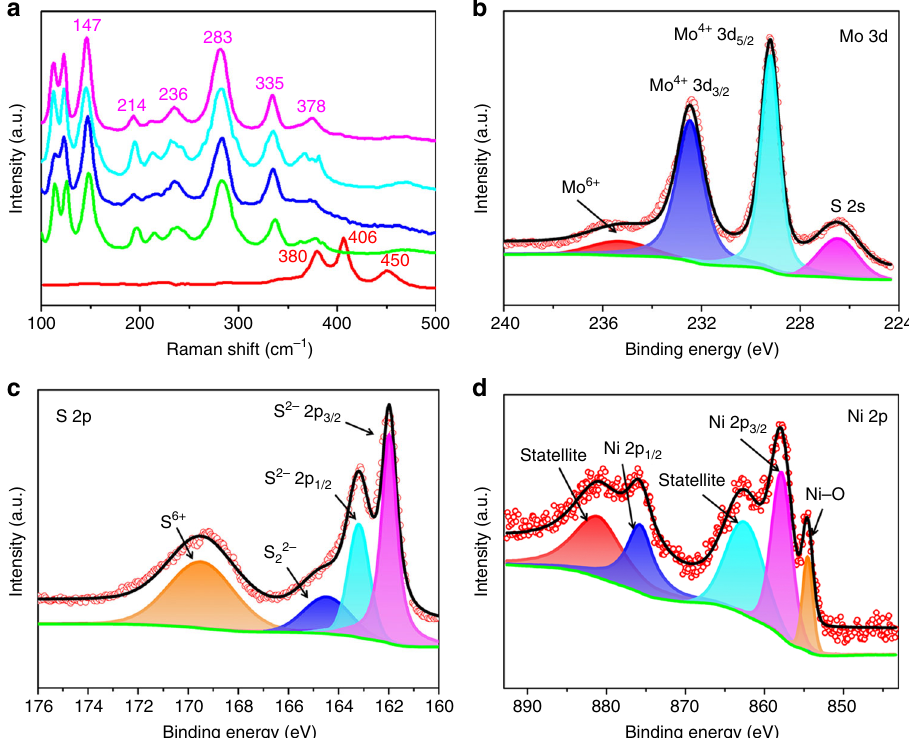
Fig. 4 Raman and XPS spectra. a Raman spectra of each XO@1T-MoS 2 nanosheet (red: 2H-MoS 2 ; green: 1T-MoS 2 ; blue: FeO@1T-MoS 2 ; light